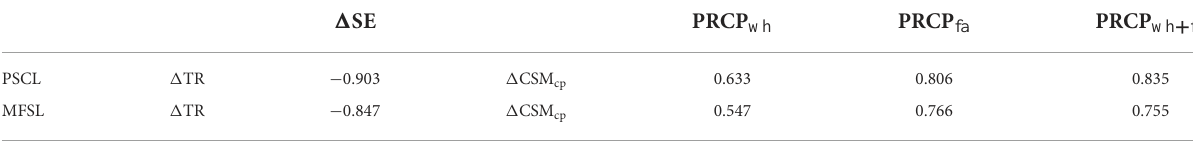
TABLE 2 Pearson correlations ( ρ ) of transpiration ( 1 TR) vs. surface evaporation effects ( 1 SE) and column soil moisture effects at cotton planting ( 1 CSM cp ) vs. precipitation totals (PRCP) in the PSCL and MFSL